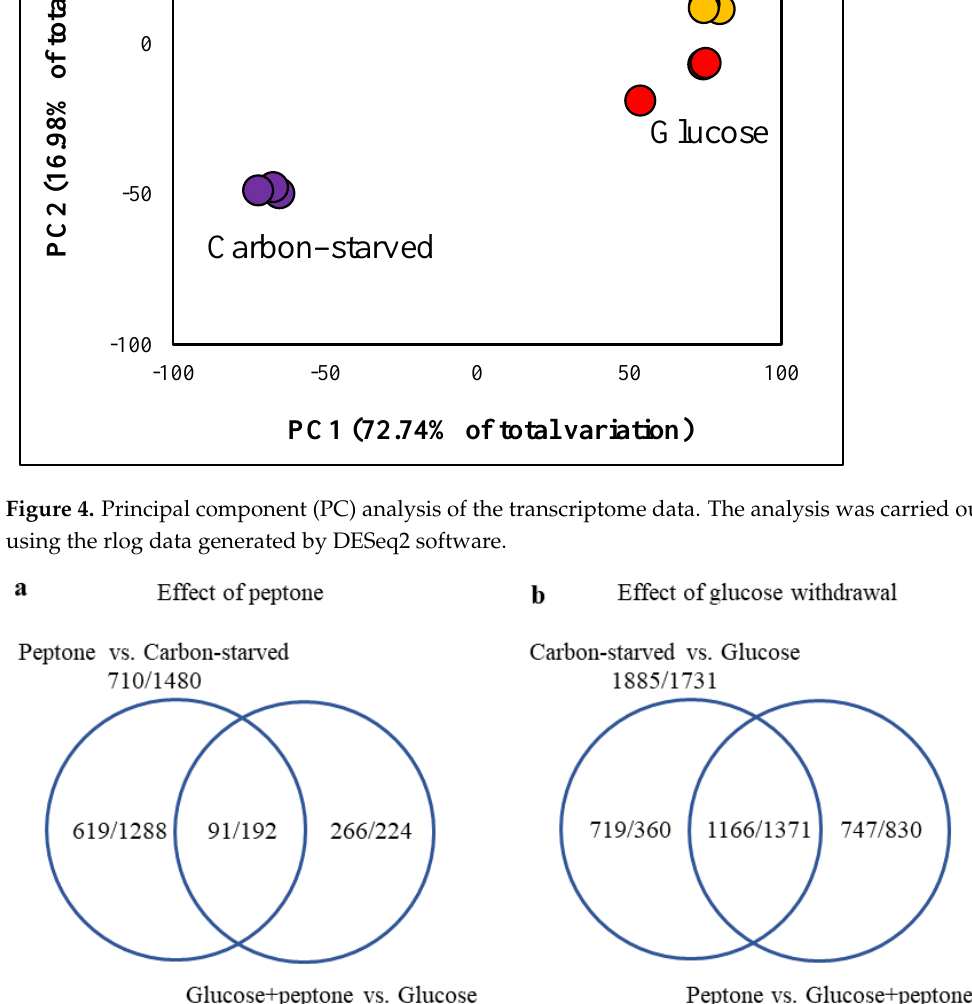
Figure 5. Distribution of genes upregulated and downregulated in the presence of peptone ( a ) or in the absence of glucose ( b ).